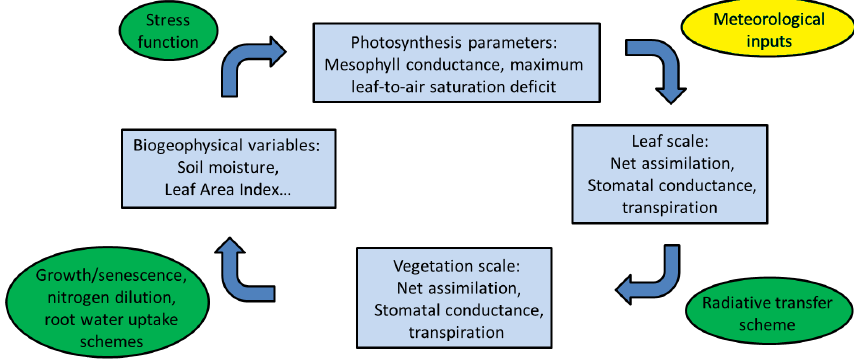
Figure 3. Relation of biogeophysical variables to leaf-scale and vegetation-scale fluxes in the ISBA-A-gs